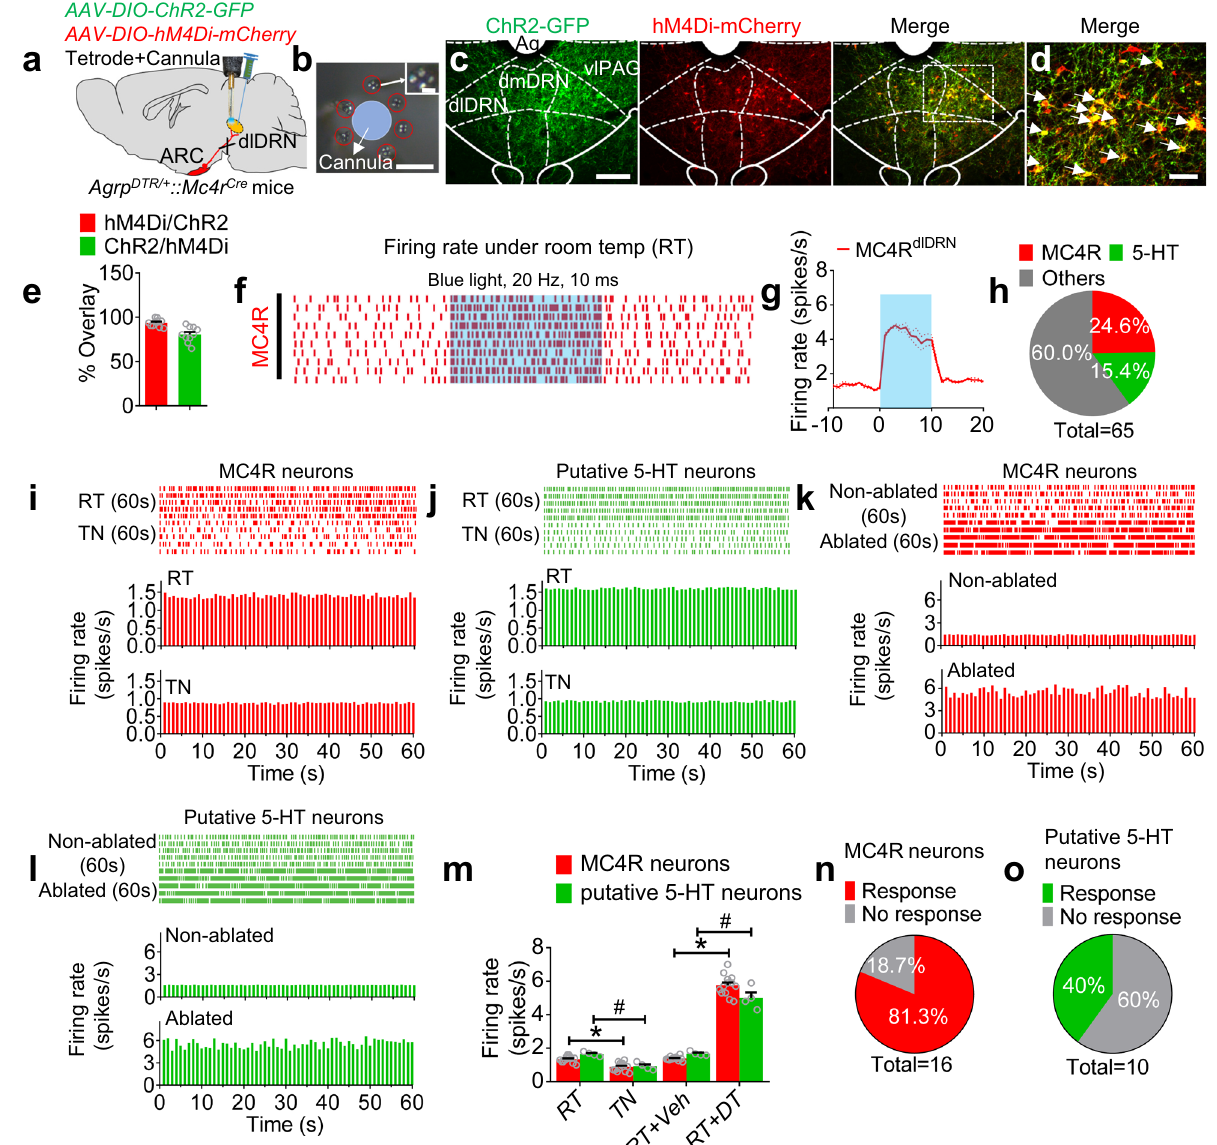
Fig. 3 The MC4R dlDRN and 5-HT dmDRN neurons are fi ne-tuned by AgRP neurons and ambient temperature. a Diagram showing in vivo optrode recording in the dlDRN of Agrp DTR/ + ::Mc4r Cre mice after injection of AAV2-DIO-ChR2-GFP and AAV2-DIO-hM4Di-mCherry into the dlDRN. b Representative image showing a tetrode bundle consisting of seven tetrodes surrounding a cannula. The inset shows a magni fi ed picture of one single tetrode. Scale bar in b , 300 µ m; scale bar in inset, 50 µ m. c , d Representative images showing ChR2-GFP and hM4Di-mCherry in the dlDRN of the mice described in a . Scale bar in c , 200 µ m; scale bar in d , 100 µ m. e Overlap of ChR2 and hM4Di. ( n = 10 brain sections from four animals per group). f , g Raster plots ( f ) and fi ring rate ( g ) of representative MC4R dlDRN neurons before, during, and after photostimulation under RT (room temperature; n = 16 trials from 16 MC4R dlDRN neurons). h The percentage of MC4R and putative 5-HT neurons out of all recorded neurons in the dlDRN. i , j Raster plots (above) and histograms (below) of fi ring rate of MC4R dlDRN neurons ( i ) and putative 5-HT dmDRN neurons ( j ) under RT and TN (thermoneutral) conditions. k , l Raster plots and histograms of fi ring rates of MC4R dlDRN neurons ( k ) and 5-HT dmDRN neurons ( l ) under RT conditions with or without AgRP ARC → dlDRN neurons ablated by DT. m Firing rates in MC4R dlDRN neurons and putative 5-HT dmDRN neurons under RT, TN conditions, with or without ablation of AgRP ARC → dlDRN neurons. ( n = 13 for MC4R dlDRN neurons, n = 4 for 5-HT dmDRN neurons; F = 411.9; for MC4R dlDRN neurons, * P = 0.0077 RT vs TN, * P < 0.0001 RT + Veh vs RT + DT; for 5-HT dmDRN neurons, # P = 0.0316 RT vs TN, # P < 0.0001 RT + Veh vs DT + RT; two-way ANOVA followed by Bonferroni post hoc test). n , o The percentage of MC4R dlDRN neurons ( n ) and putative 5-HT dmDRN neurons ( o ) responding to the RT condition. Error bars represent mean ± s.e.m. increased core body and iBAT temperatures were fully rescued by mediate thermogenesis and energy expenditure by signaling to 5- SR59230A, a selective β 3 adrenergic receptor ( β -3AR) antagonist HT dmDRN neurons via the MC4R dlDRN neurons. (Supplementary Fig. 24a). Furthermore, functional blockage of β - 3AR completely abolished the increase of core body and iBAT The AgRP ARC → MC4R dlDRN → 5-HT dmDRN neural circuit temperatures induced by activation of MC4R dlDRN neurons or 5- mediates energy expenditure by acting through iBAT and beige HT dmDRN neurons (Supplementary Fig. 24b, c). These data WAT . In the AgRP ARC → dlDRN neuron-ablated mice model, the NATURE COMMUNICATIONS| (2021) 12:3525